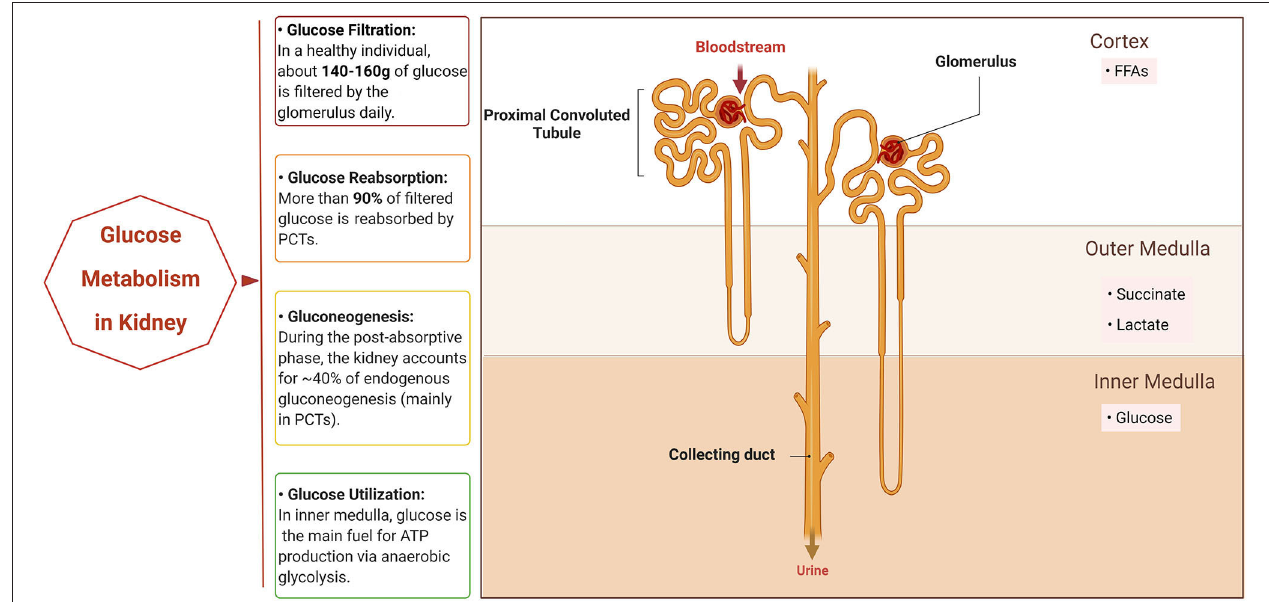
FIGURE 1 | Glucose metabolism in normal kidney. The normal kidney is involved in systemic glucose metabolism mainly in three ways: reabsorption of glucose, production of glucose (gluconeogenesis), and utilization of glucose. When the bloodstream floods into the kidneys, all of the glucose in plasma passes through the glomerulus and most is then reabsorbed by the proximal convoluted tubules (PCTs). In addition, PCTs produce glucose through gluconeogenesis during the post-absorptive phase. Different segments of the nephron have their own preferable sources of fuels for energy based on oxygen availability. PCTs in the cortex prefer free fatty acids (FFAs) for respiration, while succinate and lactate are the main fuel for the outer medulla tubules and the inner medulla mainly utilizes glucose via anaerobic glycolysis to generate ATP. Created with